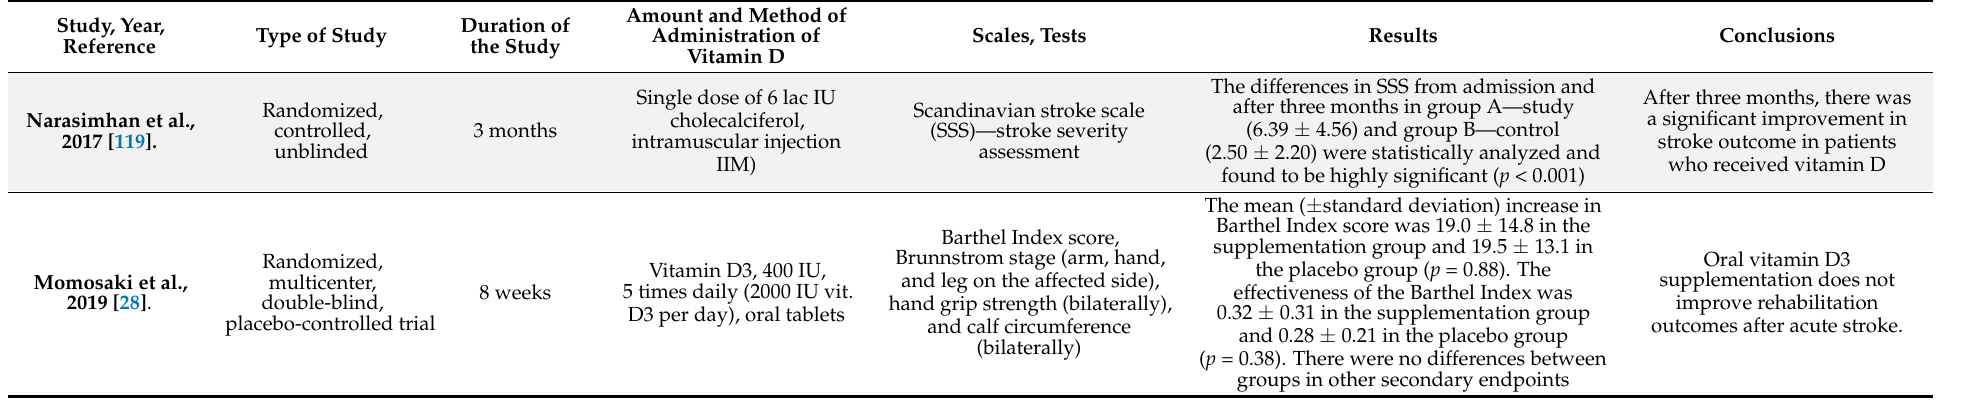
Table 2. Comparison of studies on vitamin D supplementation in patients after